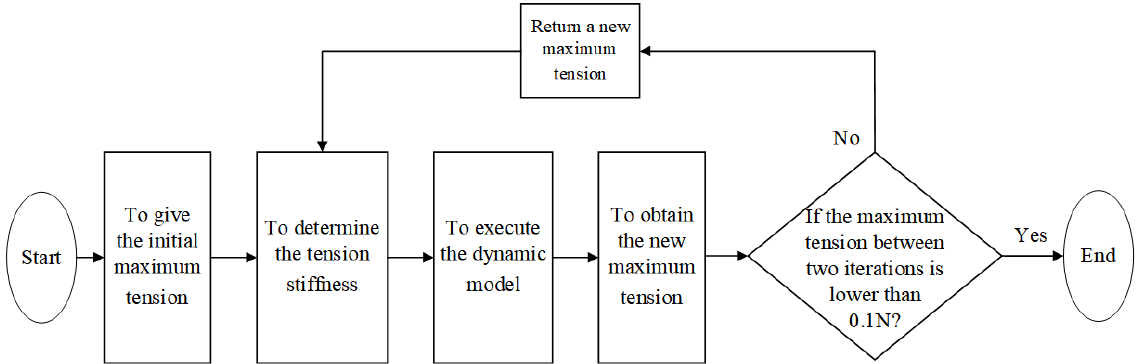
Figure 8. Flowchart of procedure to determine tether stiffness.